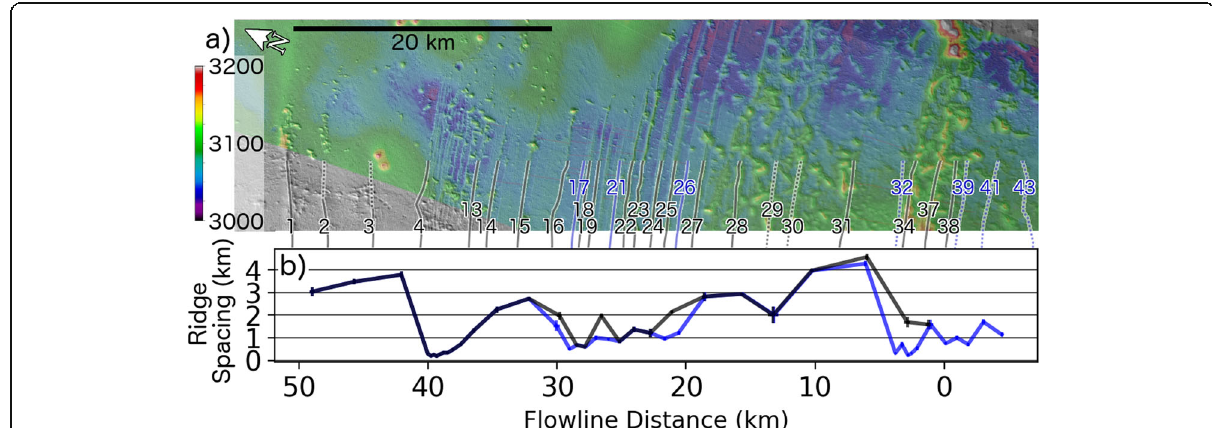
Fig. 3 CTX imagery shown with transparent stereo topography of interior ridge sequence and calculated ridge spacing. a Section of CTX global mosaic (rotated to correspond to the x-axis of b ) illustrating the emergence of parallel ridges from beneath the smooth unit (upper left) with black lines/numbers indicating ridges which are distinct in both CTX imagery and the stereo DEM (blue ridges are indistinct in one of these datasets). Dotted lines indicate poor ridge expression at this location, but, if black, has a more distinct section further to the east. b Mean spacing between individual ridge pairs (using three to five measurements per ridge pair) as a function of distance along model flowline (Fig. 1b) with error bars reflecting the standard deviation in the spacing between ridge pairs (generally smaller than the line width). The black line indicates spacing between high-confidence ridges only whereas blue line includes all ridges the positions of points along the x-axis of Fig. 3b lie ap- proximately halfway between ridges shown in Fig. 3a.